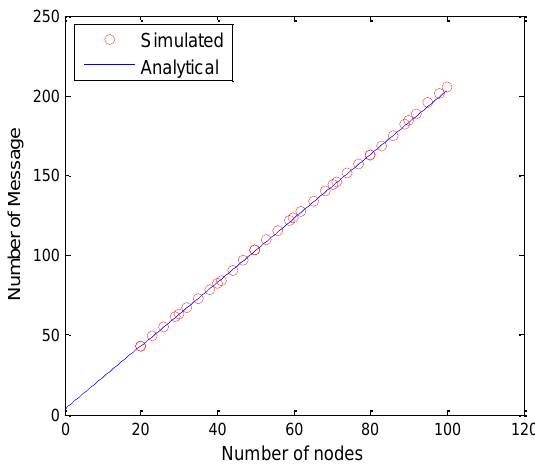
Figure 6. Analysis of message complexity.